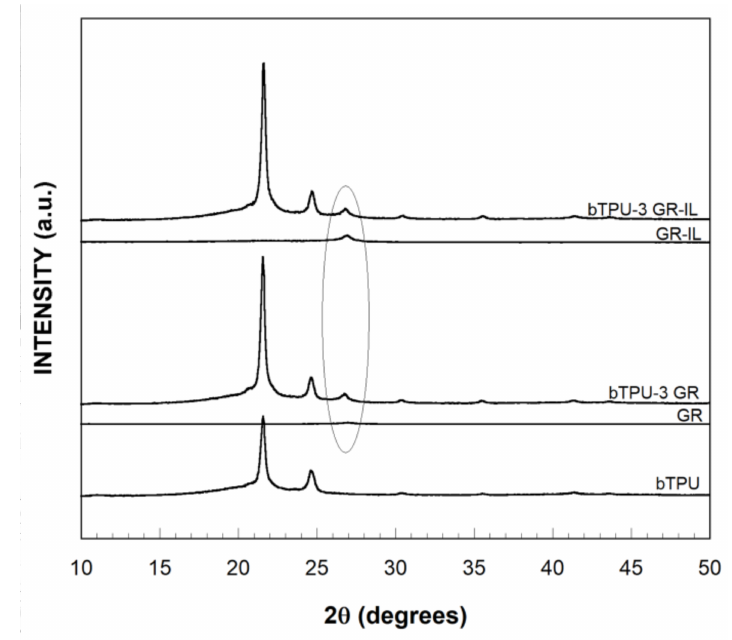
Figure 1. XRD diffractograms of the neat components and the bTPU-3 GR and bTPU-3 GR-IL NCs. The circle indicates the typical position of the corresponding peak of ordered